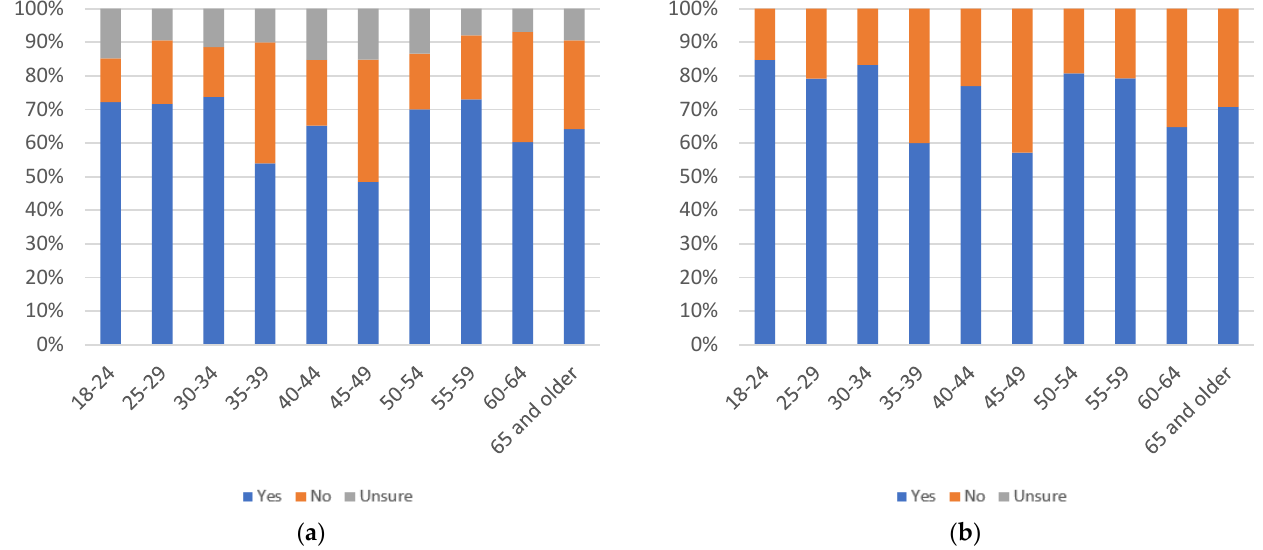
Figure 69. Label helpfulness, by age group: ( a ) with uncertain respondents (left) and ( b ) without uncertain respondents (right).